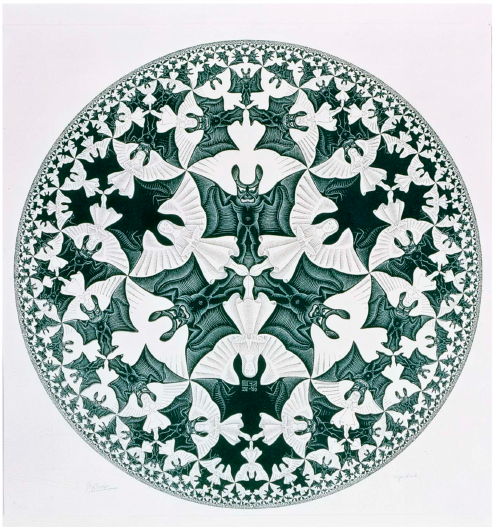
Figure 1. ‘Circle limit IV’ by the Dutch master M.C. Escher, which can be considered as a Western visualization of the Eastern Tai Ji symbol. Depending on your perspective, it might on the one hand depict—as described in verse 2 of the Tao Te Ching by Laozi—how opposites create each other. On the other hand, it might also symbolize the unification of two seemingly opposing worlds. This picture is used with the permission of the copyright owner. © 2023 The M.C. Escher Company-The Netherlands. All rights reserved. www.mcescher.com (accessed on 2 March